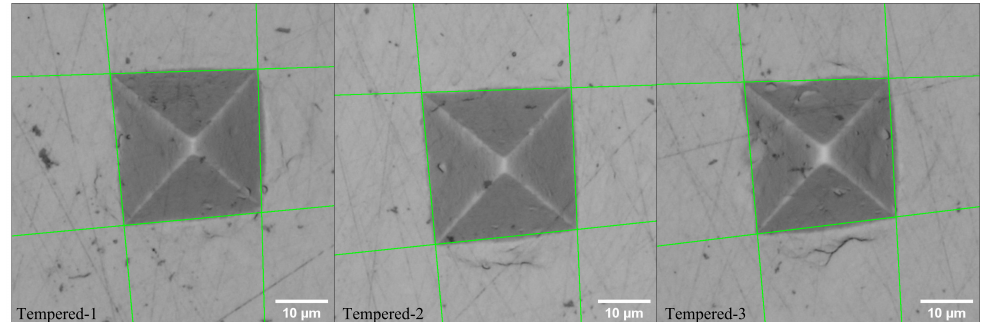
Figure A1. Corner detection on Tempering samples at 5N applied